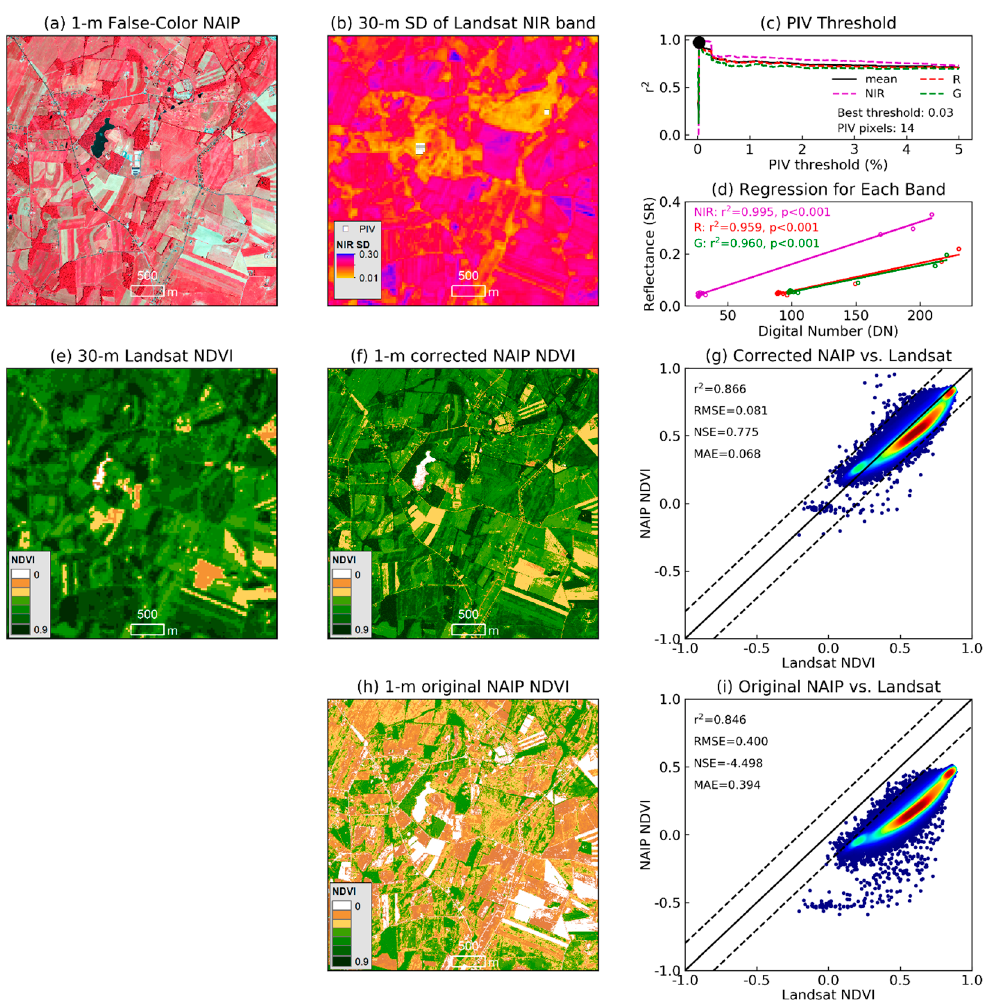
Figure 5. Application of PINT at site 2. Plots ( a )–( d ) demonstrate the identification of pseudoinvariant (PIV) pixels: plot ( a ) shows the 1 m false-color National Agriculture Imagery Program (NAIP) image (near-infrared (NIR), red and green bands) before radiometric correction; plot ( b ) shows pseudoinvariant features (white squares) identified from the 10 year NIR standard deviation of Landsat TM and ETM+ images; plot ( c ) demonstrates the identification of the best threshold (0.01st percentile); and plot ( d ) shows the linear regressions of Landsat surface reflectance and NAIP digital numbers based on pseudoinvariant pixels. Plots ( e )–( i ) show the validation of the normalized difference vegetation index (NDVI) values: plot ( e ) shows 30 m Landsat NDVI as the reference; plots ( f ) and ( h ) show 1 m NAIP NDVI before and after correction, respectively; and plots ( g ) and ( i ) show the agreement with Landsat reference before and after correction, respectively. The solid line is the 1:1 line, indicating a perfect match between NAIP and Landsat NDVI values, and the dashed lines represent the upper and lower 10% error bounds.